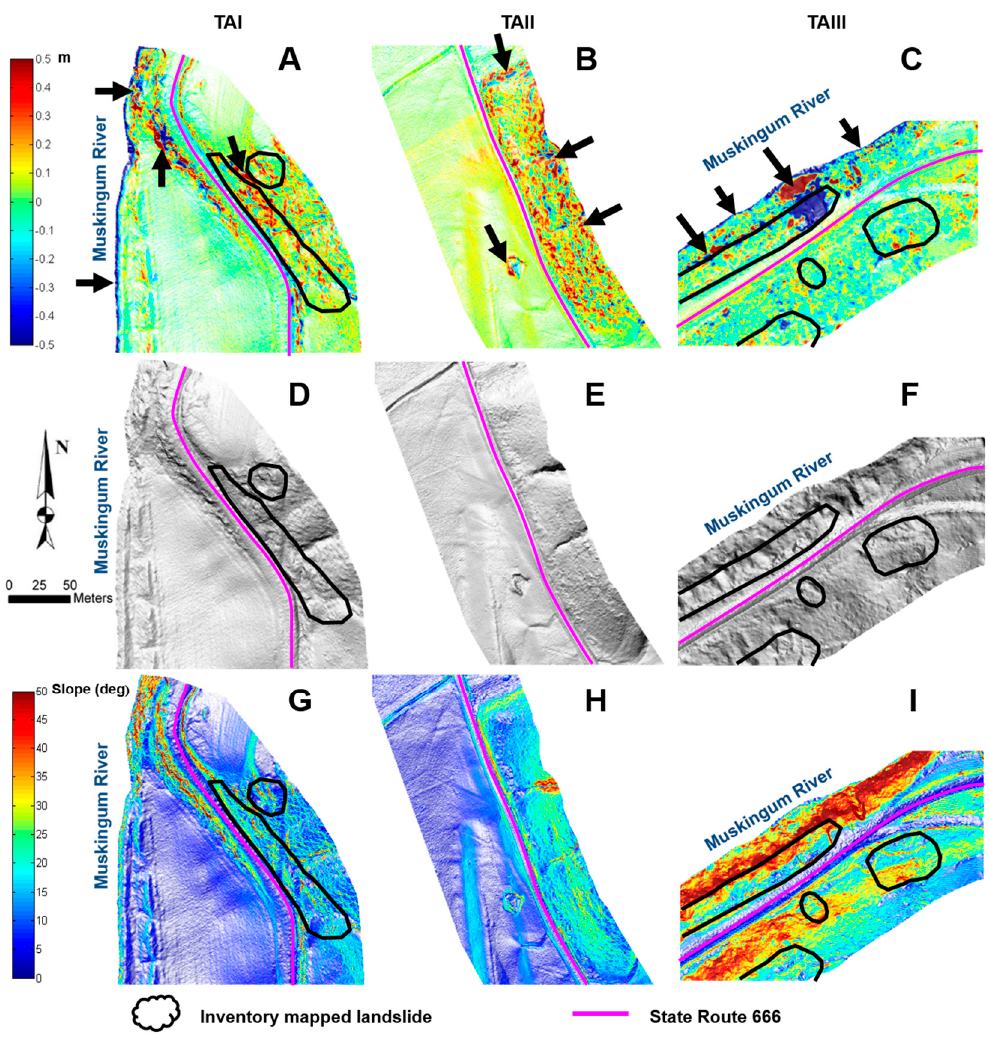
Figure 6. DoD maps (top) are shown in ( A – C ). Hillshade maps (middle) are shown in ( D – F ) for the 2012 DEM. Slope maps (bottom) are shown in ( G – I ) for the 2012 DEM. Examples of areas experiencing vertical changes are depicted by black arrows.